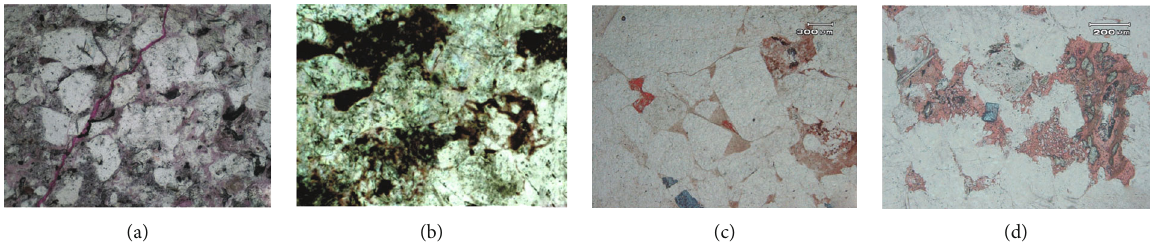
Figure 5: Characteristics of pore types in the Upper Paleozoic Erathem sandstone of the study area. (a) Intergranular pores and fractures, Zitan 1 well, He 8 section, 3736.19m; (b) intergranular pores and intragranular pores, Zhentan 2 well, Shan 1 section, 2893.10m; (c) residual intergranular pores and intergranular dissolution pores, Ling 1 well, Shan 1 section, 3469.69m; (d) intergranular pores and intragranular pores, Qingtan 2 well, Shan 1 section,